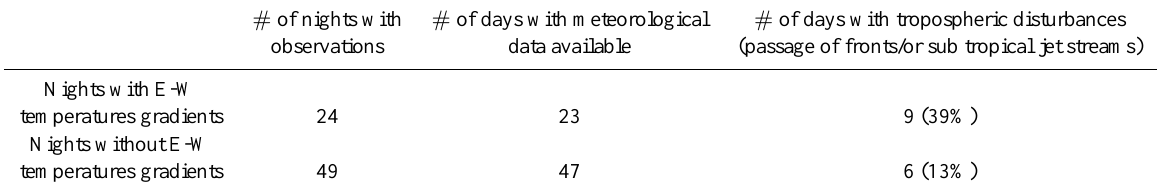
Table 3. Details of tropospheric disturbances in the region of observation on the nights of measurements with/without thermospheric temperature gradients (Source: Climanalise, a monthly publication by INPE) # of nights with # of days with meteorological # of days with tropospheric disturbances observations data available (passage of fronts/or sub tropical jet streams) Nights with